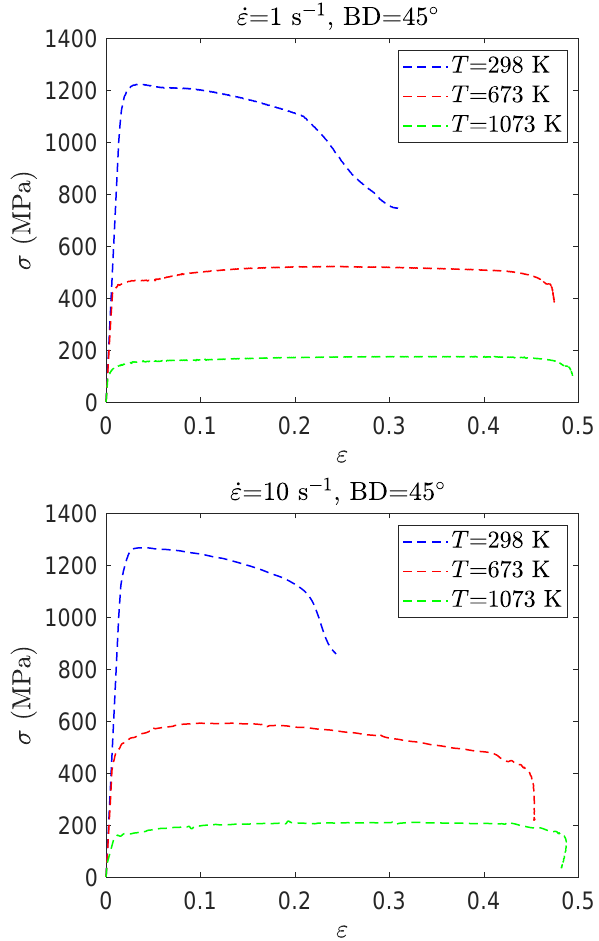
Figure 7. Stress–strain curves for the compression tests carried out at different temperatures (298 K, 673 K, and 1073 K, as well as two strain rates (1 s − 1 and 10 s − 1 ), on Ti42Nb titanium alloy produced with a building direction of 45 ◦